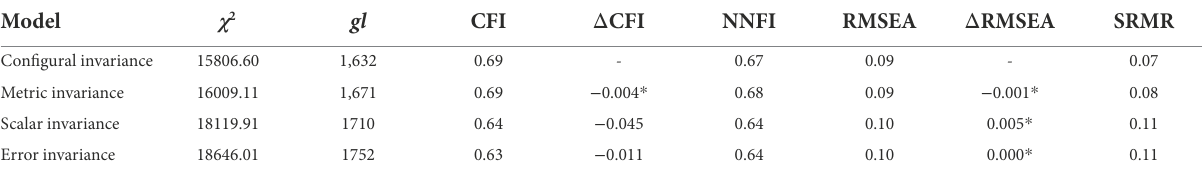
TABLE 8 Fit index values for obtaining evidence of factorial invariance as a function of the origin of the activity. Model